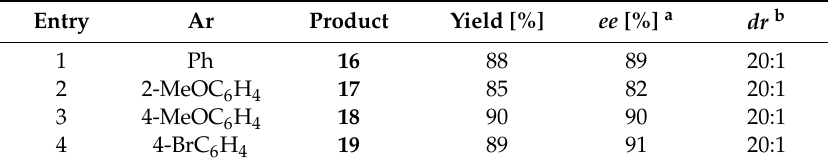
Scheme 4. Enantioselective Mannich reaction catalyzed by aziridine 9 . Table 2. Asymmetric Mannich reaction in the presence of aziridine 9 Table 2. Asymmetric Mannich reaction in the presence of aziridine 9 .